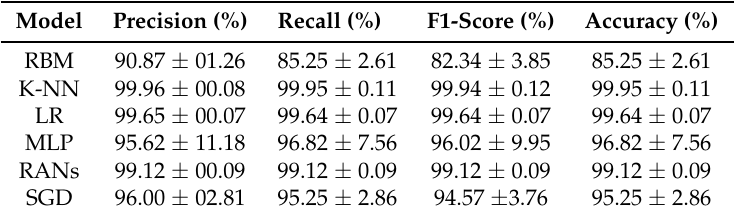
Table 2. RAN’s Comparative Study for Toy-data.